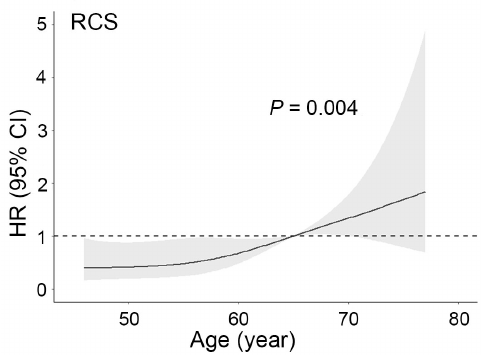
Figure 3. Nonlinear dependence between the risk of death and age in NSCLC patients with N2 stage who received chemotherapy and neoadjuvant radiotherapy. Note: NSCLC, non ‐ small cell lung cancer; RCS, restricted cubic splines; HR, hazard ratio; CI, confidence interval.